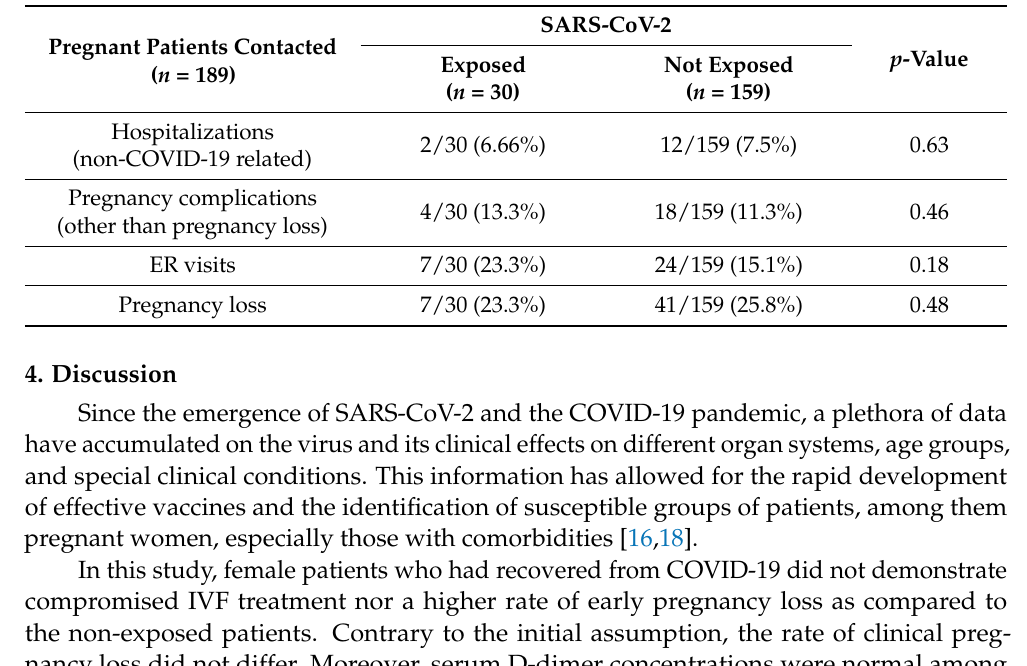
Table 3. Pregnancy outcomes of COVID-19-exposed versus non-exposed IVF